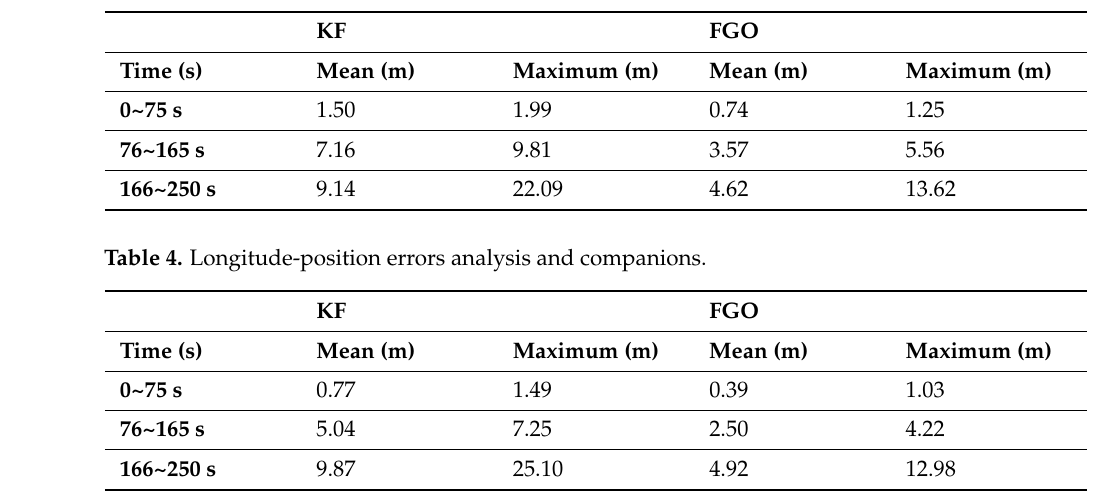
Figure 10. Position errors. ( a ) Latitude errors. ( b ) Longitude errors. Table 3. Latitude-position errors analysis and companions.